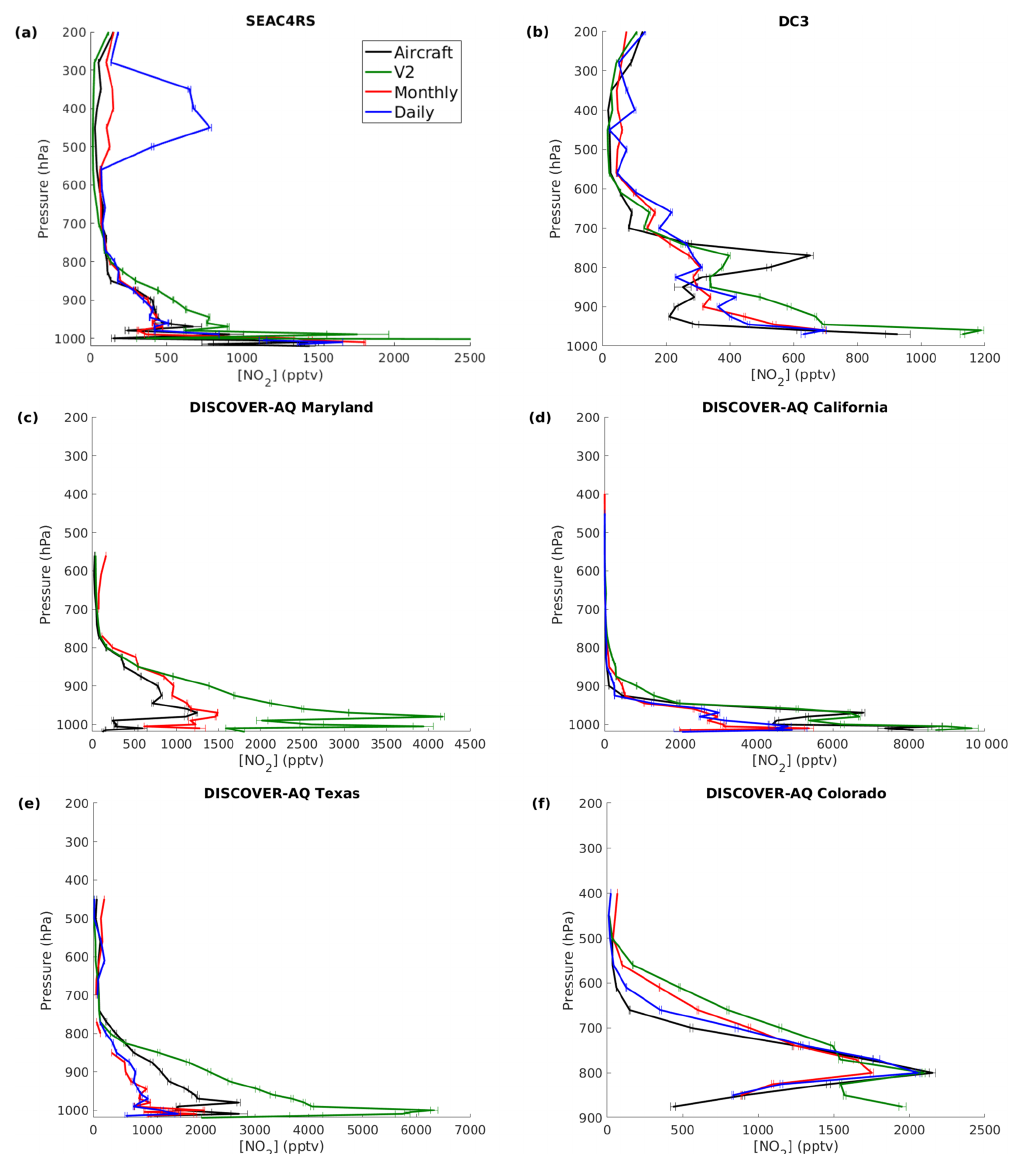
Figure 1. Comparison of average WRF-Chem and aircraft NO 2 profiles from the (a) SEAC4RS, (b) DC3, and DISCOVER-AQ campaigns, the latter in (c) Maryland, (d) California, (e) Texas, and (f) Colorado. Aircraft profiles are shown in black, BEHR v2.1 profiles in green, BEHR v3.0 monthly profiles in red, and (where available) BEHR v3.0 daily profiles in blue. The WRF and aircraft data are matched as described in Sect. 2.4 and binned by pressure. Uncertainties are 1 standard deviation of all profiles averaged. Note that for SEAC4RS the v2 profile reaches a maximum of ∼ 8000pptv, off the plot